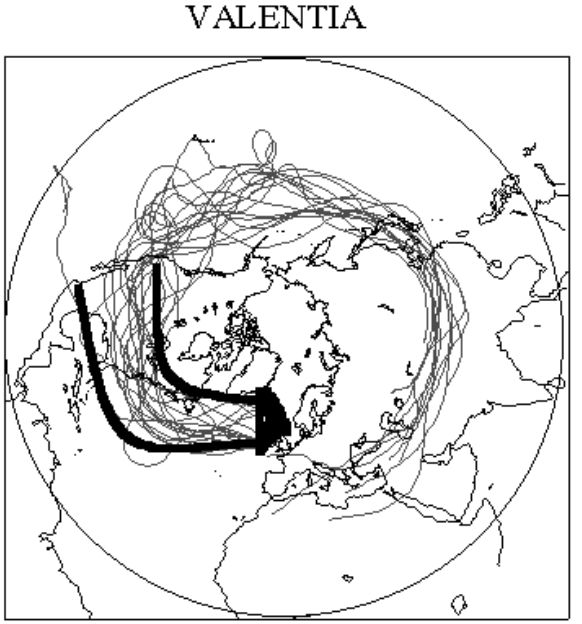
FIGURE 6 Fig. 6. Ten day backward trajectories on the 350K isentropic sur-